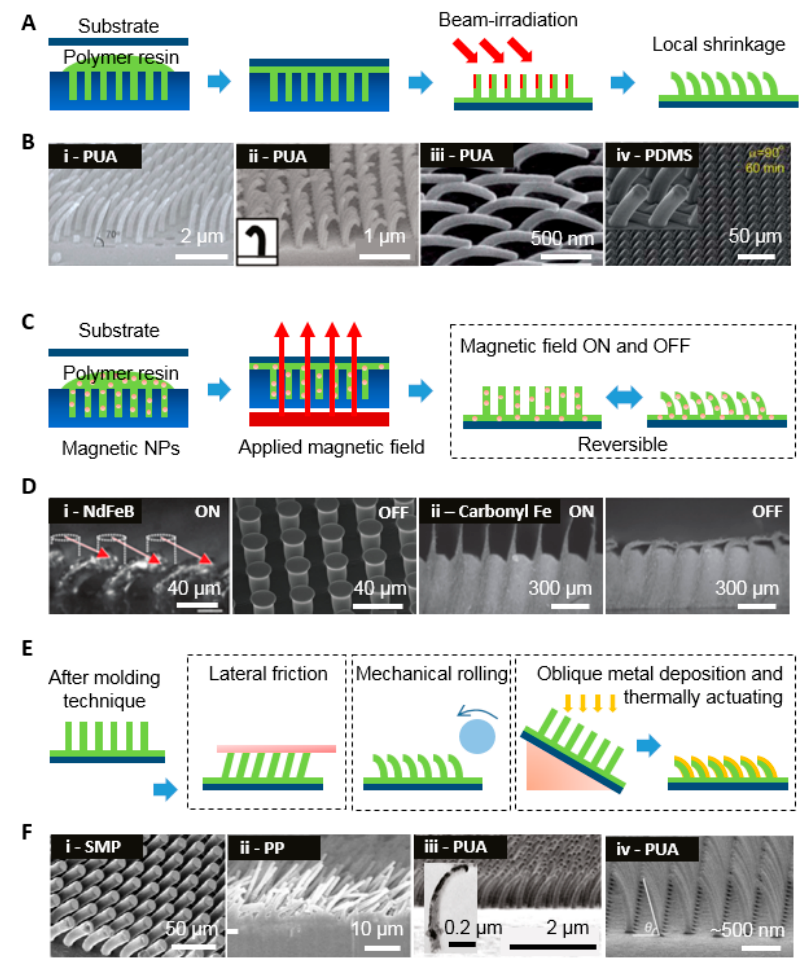
Figure 3. Schematic diagram and representative SEM images of various actuating techniques for fabricating tilted hairs. Vertical micro/nano hairs obtained by molding followed by an additional process to control the geometry of the hairs are shown. ( A , B ) Schematic procedures and SEM images for angled e-beam or ion beam irradiation ( A (i–iii) PUA and A (iv) PDMS hairs obtained by e-beam and ion beam irradiation, respectively. B (i) reproduced from [26], with permission from John Wiley & Sons. B (ii) reproduced from [50], with permission from the American Chemical Society. B